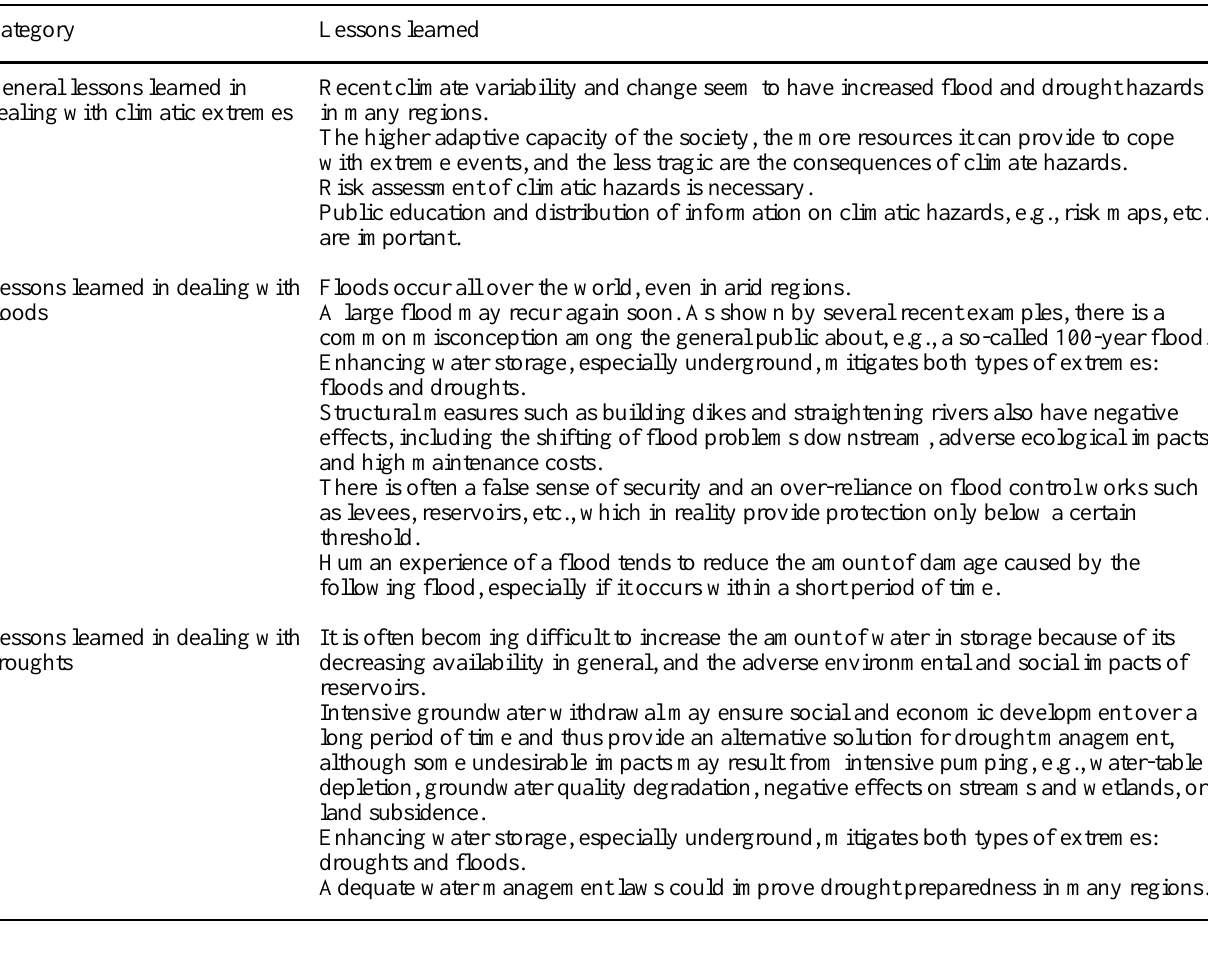
Table 9. Lessons learned in dealing with climatic extremes.